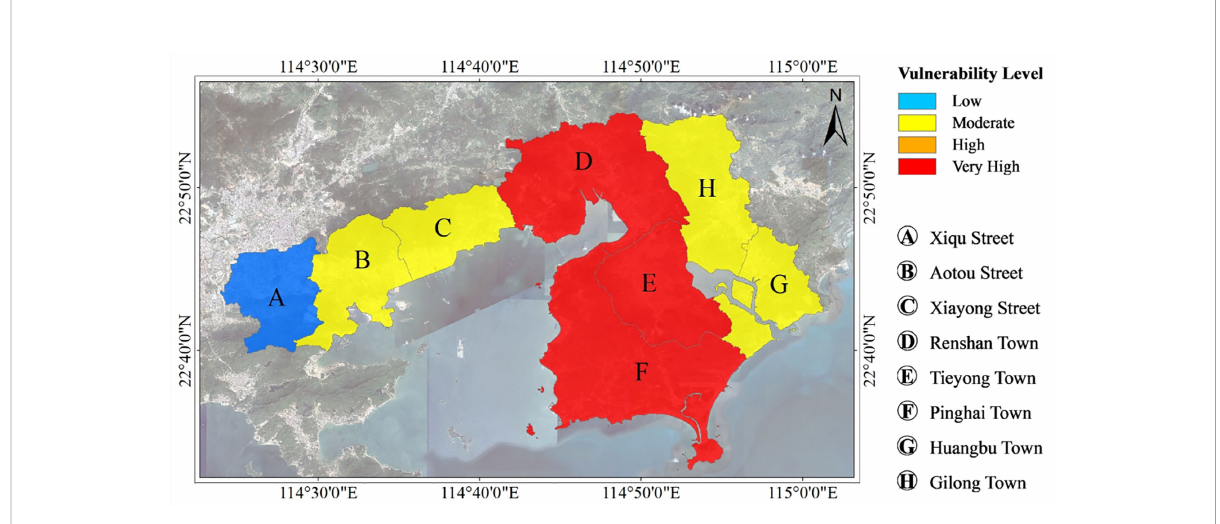
FIGURE 11 Mapping of the comparative social vulnerability of streets/towns based on the SoVI in the study